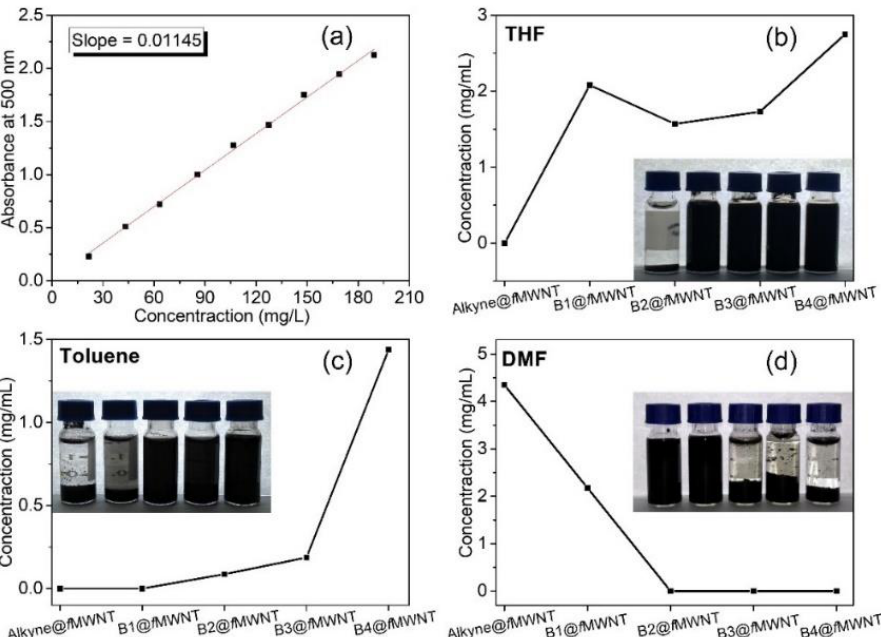
Figure 3. Optical density at 500 nm of bc@ f MWNTs in THF at different concentrations. The straight line is a linear fit to the data having a slope of 0.01145. (Note: The concentration for UV–Vis measurement has been diluted several times) ( a ), and photograph, the solubility of different block copolymer modified MWNTs in THF ( b ), toluene ( c ), and DMF ( d ) after 24 h.